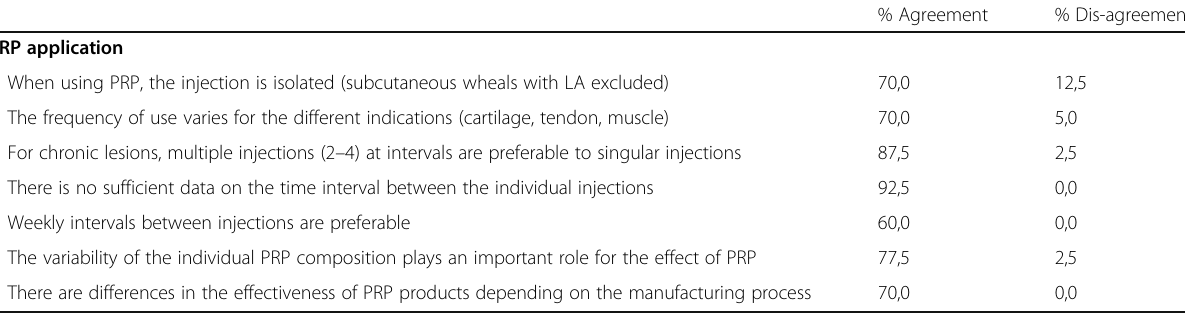
Table 4 Practical aspects of PRP application